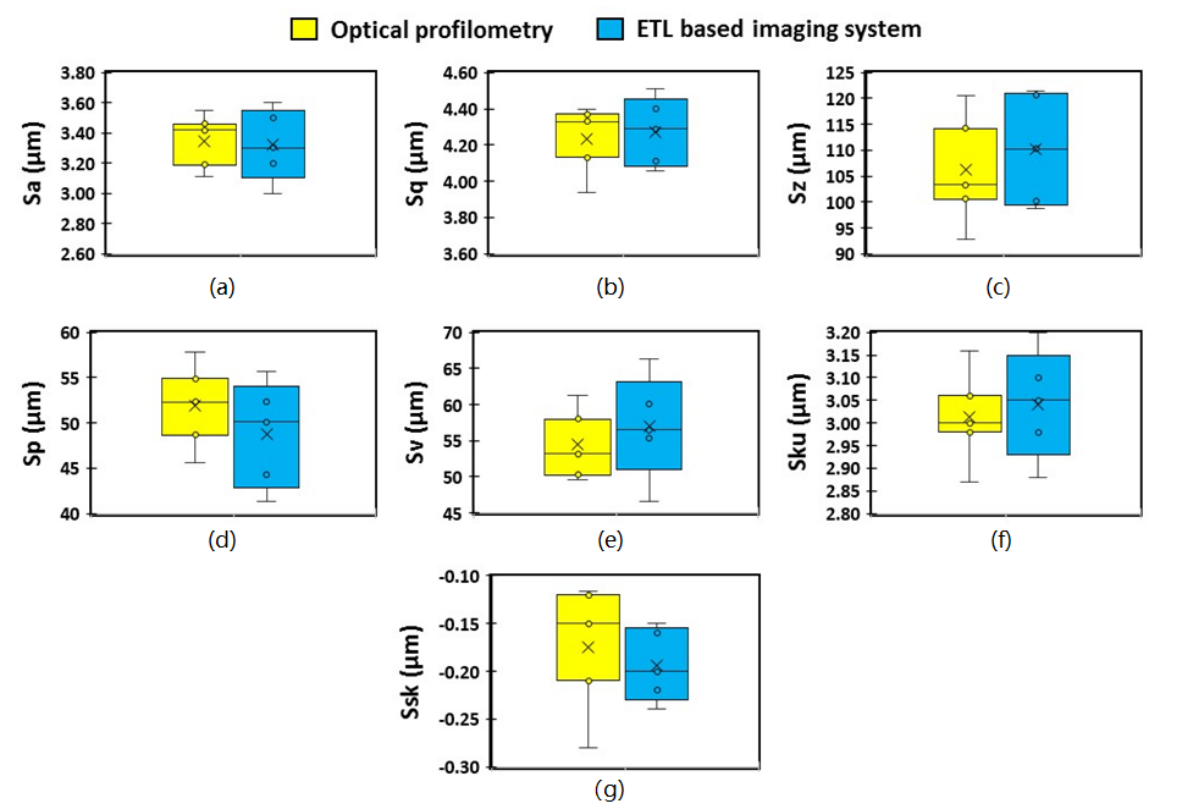
Figure 8. Amplitude and spacing parameters of 3D surface texture analysis. ( a ) S a : arithmetical average of surface; ( b ) S q : root mean squared height; ( c ) S z : deviation maximum height; ( d ) S p : highest peak of the surface; ( e ) S v : lowest valley of the surface; ( f ) S ku : kurtosis of height distribution; and ( g ) S sk : skewness of height distribution.